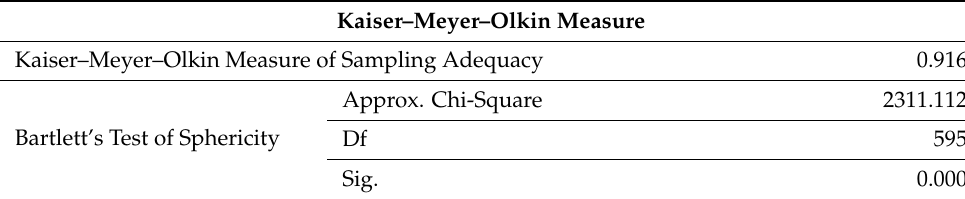
Table 3. Kaiser–Meyer–Olkin measure of sampling adequacy.